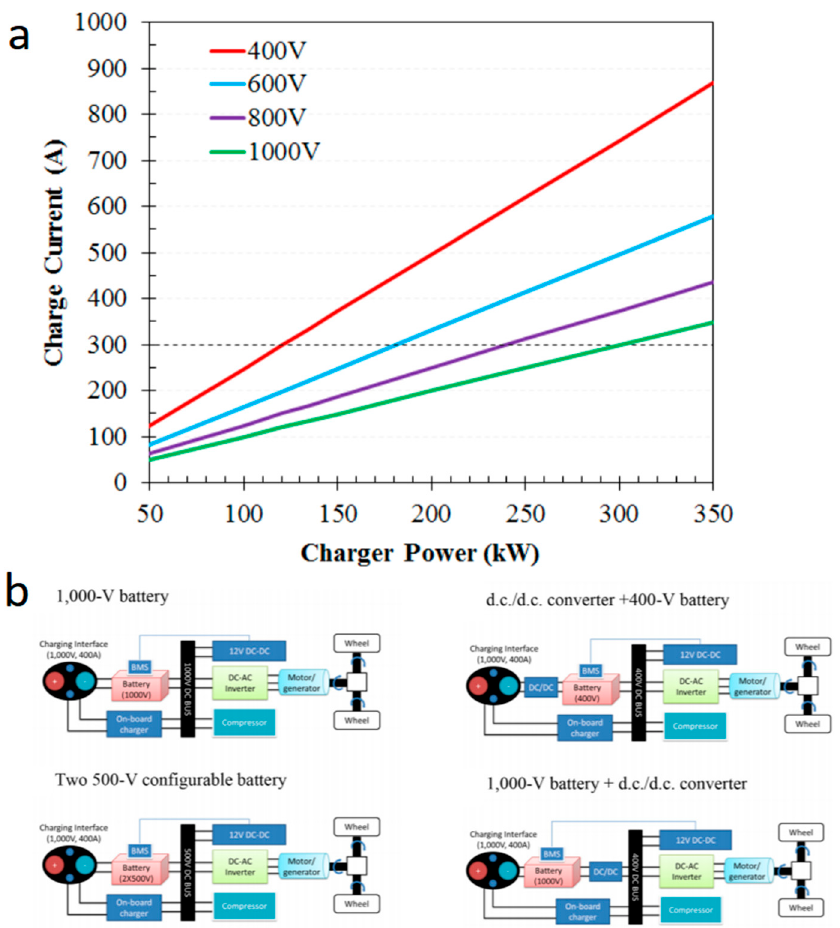
Figure 5. Charge current with respect to charge power for different battery pack voltages. The 400 V configuration shown in red is representative of a typical EV battery pack today ( a ) [51]; options for 1000 V BEV architectures ( b ) [4]. Reproduced by permission of Elsevier.